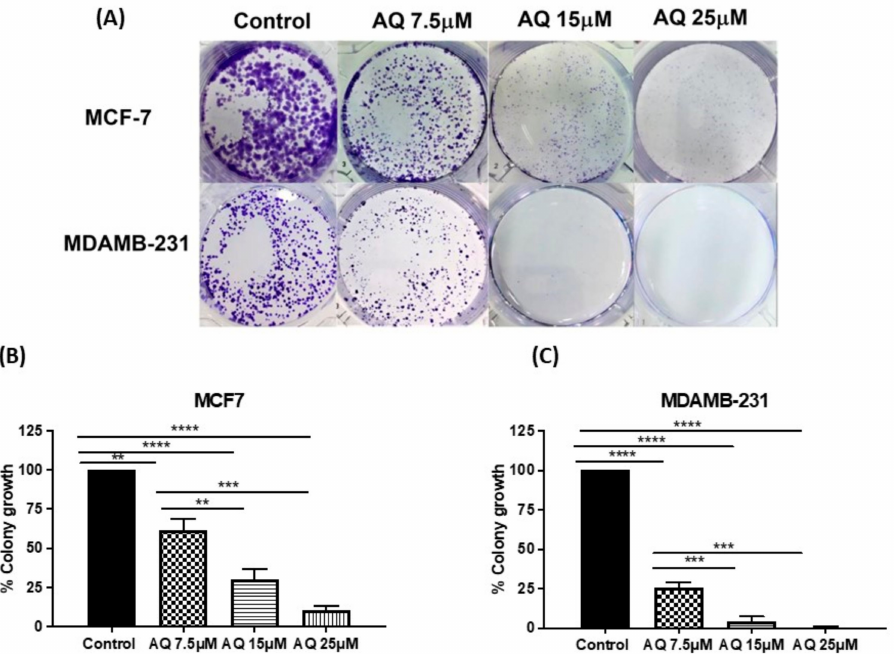
Figure 3. ( A ) Representative images showing distinct colonies after staining in MCF-7 and MDAMB- 231 cell lines. Three different experiments were performed. ( B , C ) Quantitative representation of clonogenic assay as % colony growth with AQ’s treatment as compared to control in MCF-7 and MDAMB-231 cell lines, respectively. Data represent mean ± SEM ( n = 3). ** p < 0.01, *** p < 0.001, **** p <